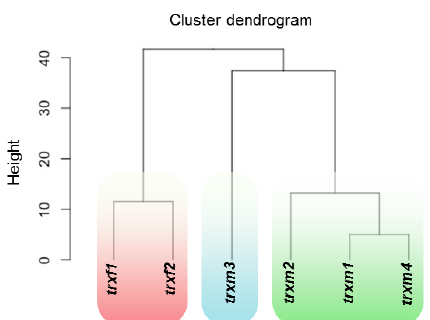
Figure 6. Hierarchical clustering segregates trx mutants according to the biological processes affected. For calculations, the R statistical environment (The R Foundation, Vienna, Austria) available at http://www.R-project.org was used.